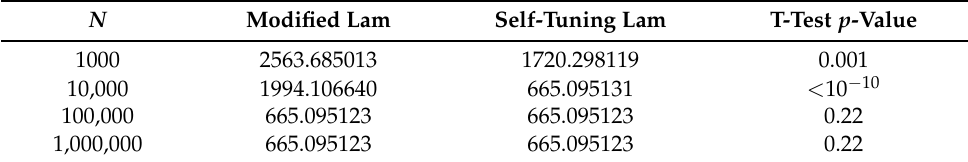
Table 14. Average solution for minimizing f 2,1000 ( x ) . The minimum is f 2,1000 ( x ) ≈ 665.095. N